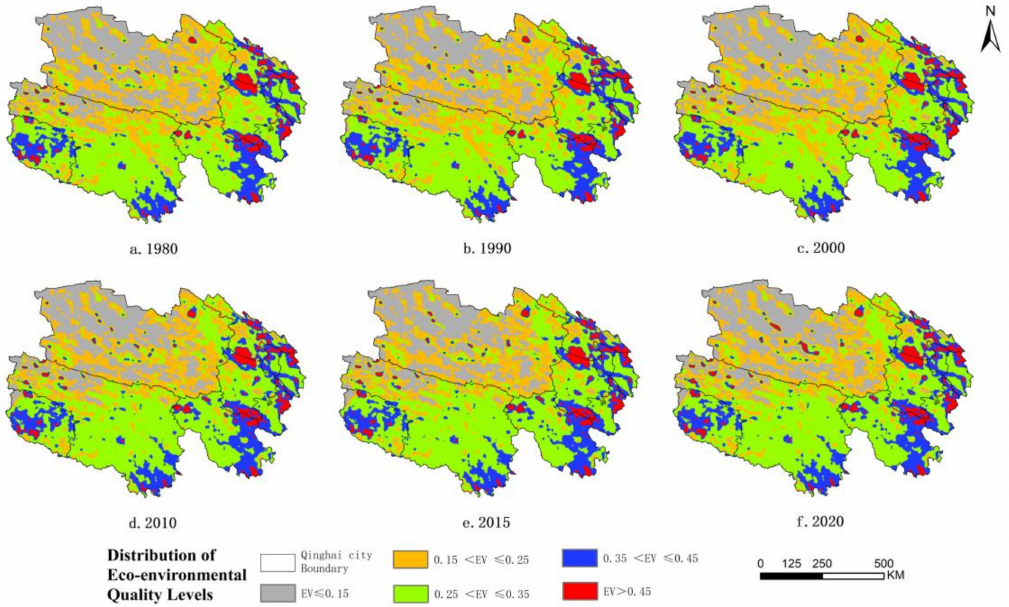
Figure 5. Distribution of eco-environmental quality levels in Qinghai Province from 1980 to 2020. Table 5. Distribution of ecological environment quality grades of Qinghai (km 2 /%).